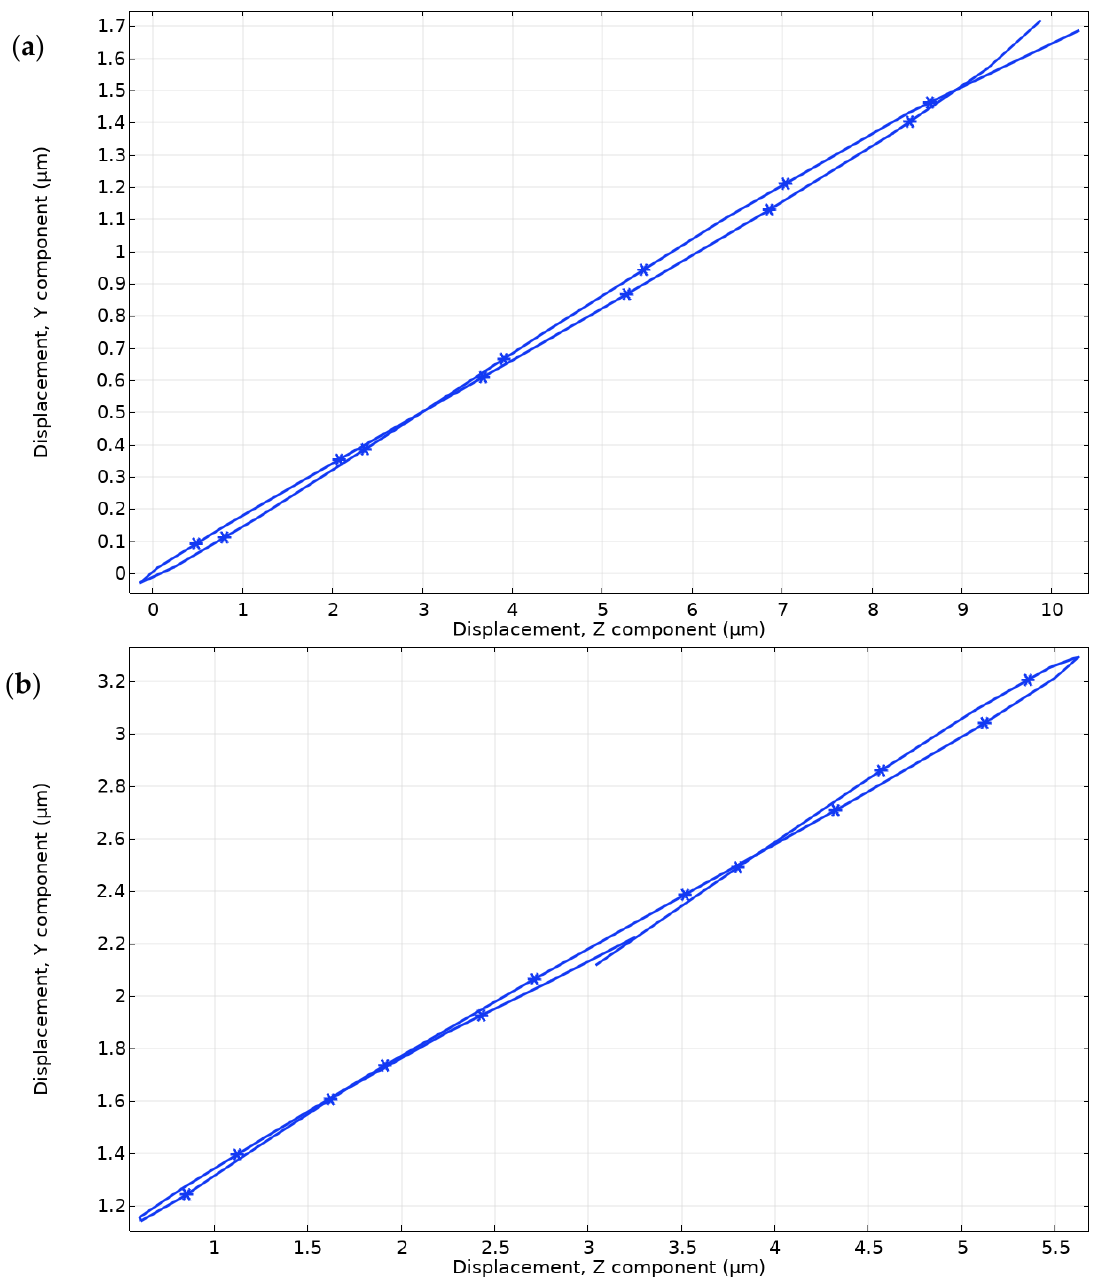
Figure 12. Motion trajectories of contact points: ( a )—motion trajectory of contact point located at the tip of trapezoidal cantilever driven by segment L 0deg ; ( b )—motion trajectory of contact point located on top of R 0deg segment.